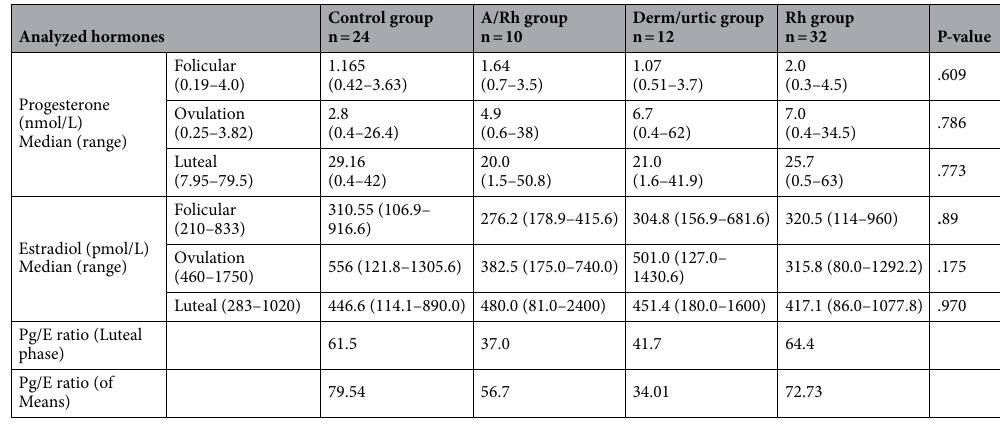
Table 3. Serum levels and the ratio of Progesterone to Estradiol in patients and controls according to phases of menstrual cycle. n—number of subjects; Pg—progesterone; E—estradiol; Rh—allergic rhinitis; A/Rh— allergic asthma with rhinitis; Derm/urtic -allergic dermatitis/acute